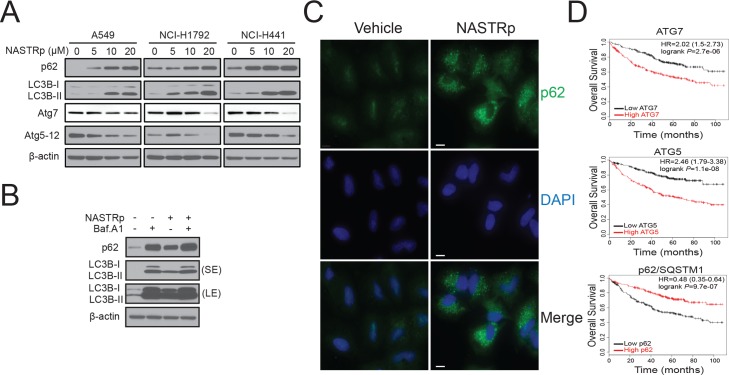
NASTRp suppresses tumor-promoting autophagy in human cancer cells.
(A) Cells were treated with various concentrations of NASTRp in RPMI-1640 media supplemented with 5% FBS for 24 hours. Cell lysates were subjected to western blot assay with the indicated antibodies. (B) Inhibition of autophagy flux by NASTRp. NCI-H441 cells were treated with 20 μM NASTRp in the presence or absence of bafilomycin A1 (100 nM) for 24 hours. Cell lysates were subjected to SDS-PAGE/Western blot analysis using the indicated antibodies. (C) Accumulation of p62 aggregates by NASTRp. A549 cells were treated with 20 μM NASTRp for 24 hours. Treated cells were followed the immunofluorescence staining with anti-p62 antibody. Scale bar: 10 μm. (D) Potential clinical benefit of NASTRp in lung adenocarcinoma patients. Kaplan-Meier survival curves for human lung adenocarcinoma datasets, which compare the overall survival between tumors with high levels (red) or low levels (black) of ATG7 (left panel), ATG5 (middle panel) and p62/SQSTM1 (right panel) gene expression from Kaplan-Meier Plotter tool. Log-rank P values are shown.